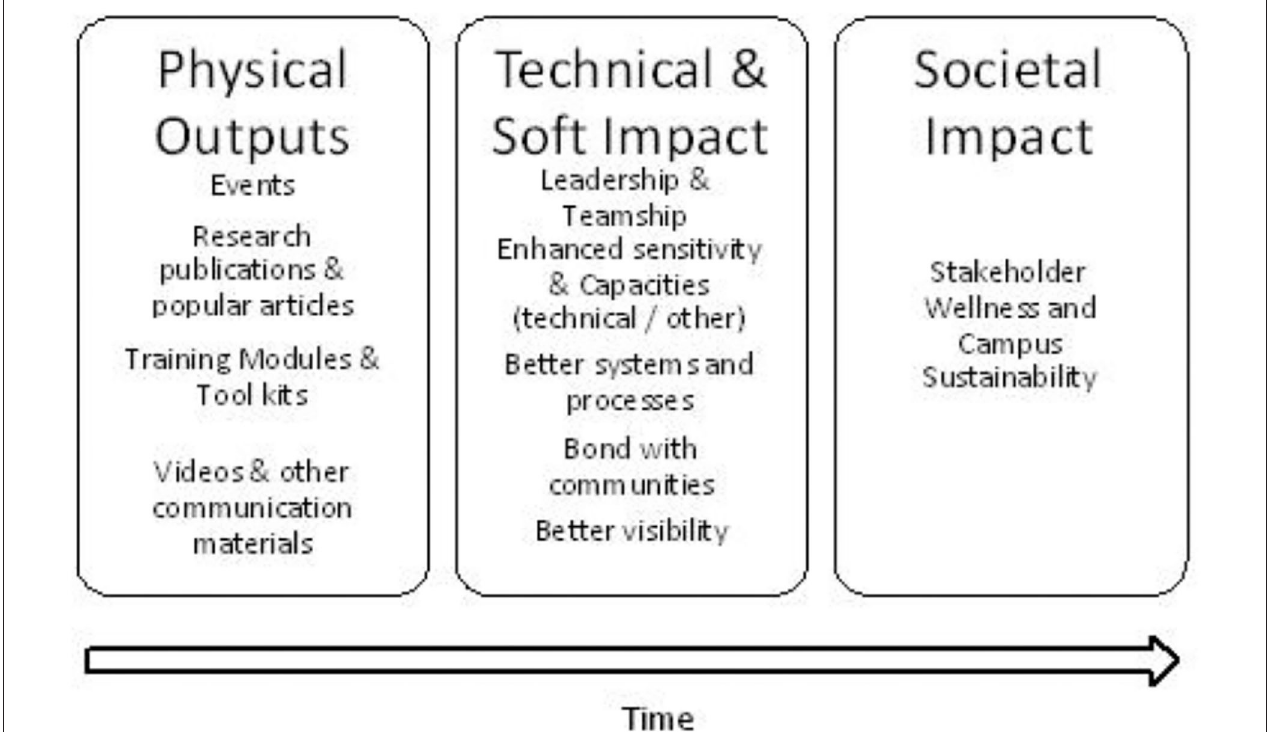
FIGURE 6 | Expected outputs from UWP over